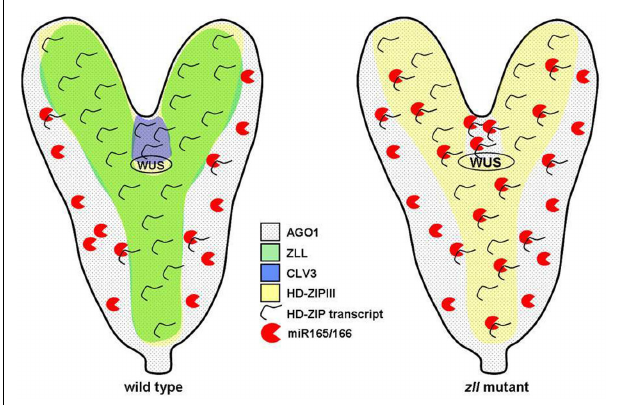
FIGURE 3 | Function ofAGO1, ZLL, and miR165/166 during embryogenesis. In wild type, ZLL protein is thought to sequester miR165/166 away from AGO1, thus allowing accumulation of HD-ZIPIII mRNA in the shoot meristem region and maintenance of stem cells (expressing CLV3 ). In the zll embryo, higher levels of miR165/166 can bind to AGO1, resulting in a reduction of HD-ZIPIII transcript levels, termination of the shoot meristem and of CLV3 expression. Gene expression domains are